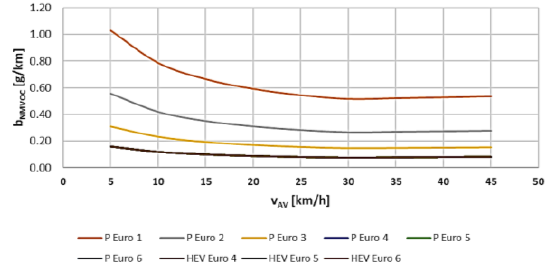
Fig. 20. NMVOC emission from petrol PCs for Euro standards depending on average speed